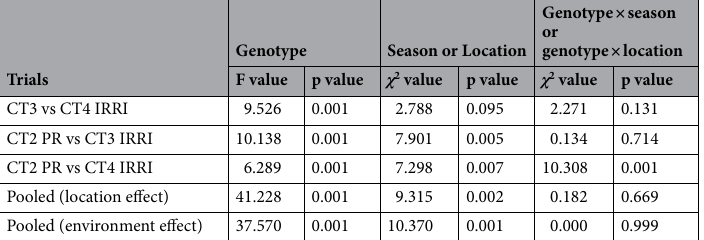
Table 4. Analysis of variance and G × E for carotenoid content. CT confined test, IRRI International Rice Research Institute, PR Philrice.